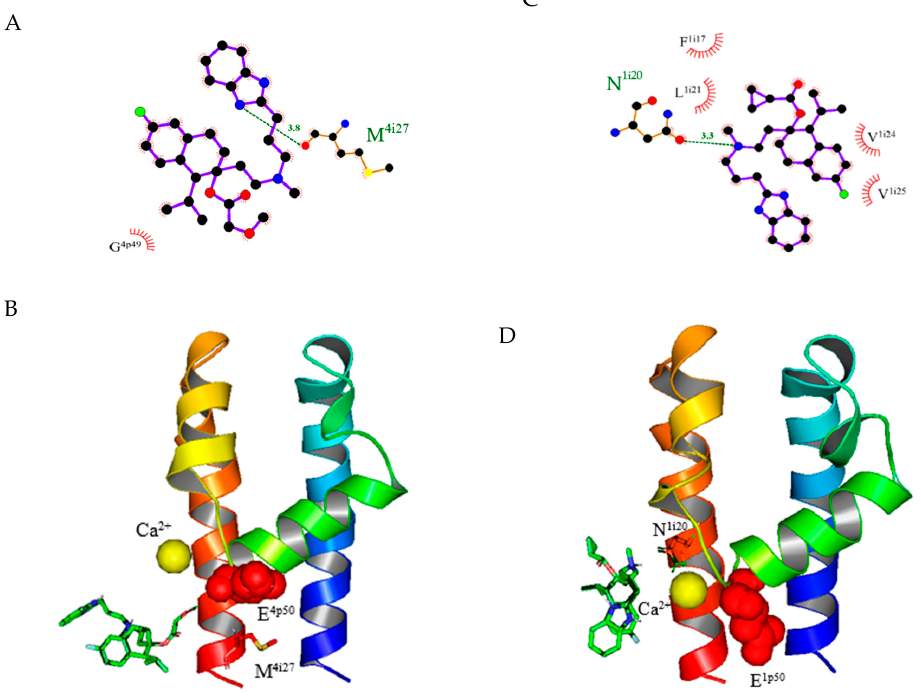
Figure 3. Models of ligand–receptor interactions of mibefradil and NNC 55-0396. ( A ) The predicted binding sites of mibefradil on α 1 C. The H-bond formed between the ammonia (N 3 ) on the cyclopentadiene of mibefradil and methionine (M 4i27 ) on domain IV. The relative locations of surrounding amino acid residues of the α 1 C L-type calcium channel (LCC) are shown by the arch–dash symbols. ( B ) The predicted 3D binding sites of mibefradil on α 1 C domain IV from a side view. Red spheres represent the position of glutamic acid E 4p50 . Mibefradil is represented by the green ring structure. ( C ) The predicted binding sites of NNC 55-0396 on α 1 G domain IV. The H-bond formed between the central ammonium of NNC 55-0396 and asparagine (N 1i20 ) on domain I. ( D ) The predicted 3D binding sites of NNC 55-0396 on α 1 G. NNC 55-0396 is represented by the green ring structure. Red spheres represent the position of glutamic acid E 4p50 . For A and C, carbon, nitrogen, oxygen, and fluorine elements are represented by black, blue, red, and green, respectively; for B and D, the blue and orange ribbon helices represent S5 and S6, respectively. The ribbon helix structures linking S5 and S6 are P-loops. The yellow ball represents the position of the calcium